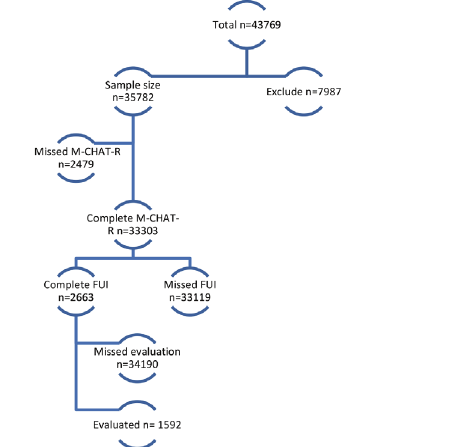
Figure 1 - Number of participants at each stage of the